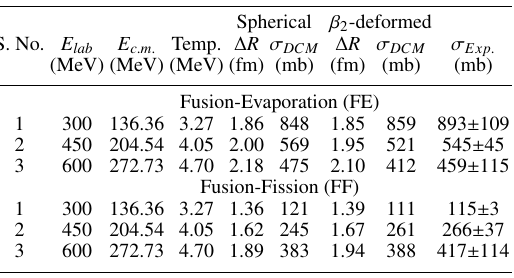
Table 1. Fusion-Evaporation (FE) and Fusion-Fission (FF) cross-sections for 48 Ti + 40 Ca → 88 Mo ∗ reaction at three given beam energies calculated using DCM and compared with the experiment data [6]